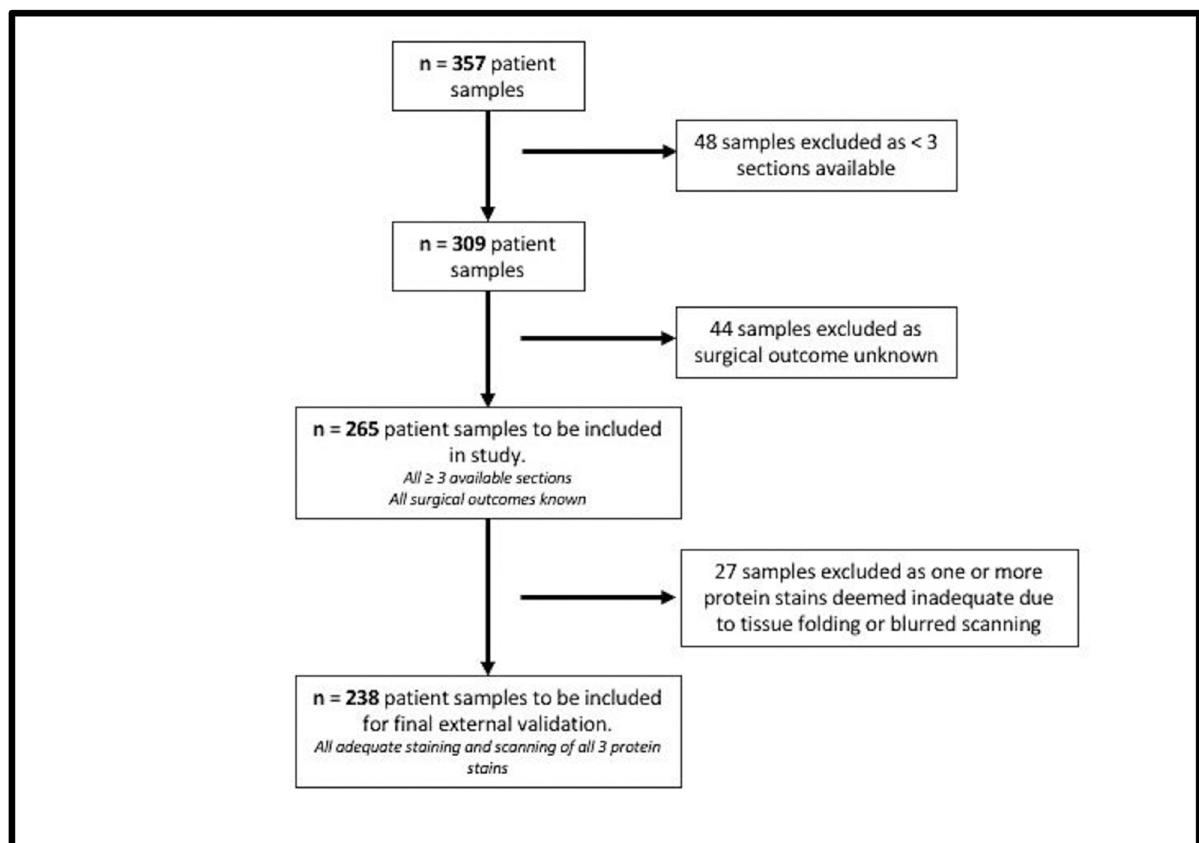
Fig 1. Consort diagram describing tumour sample selection process for inclusion in